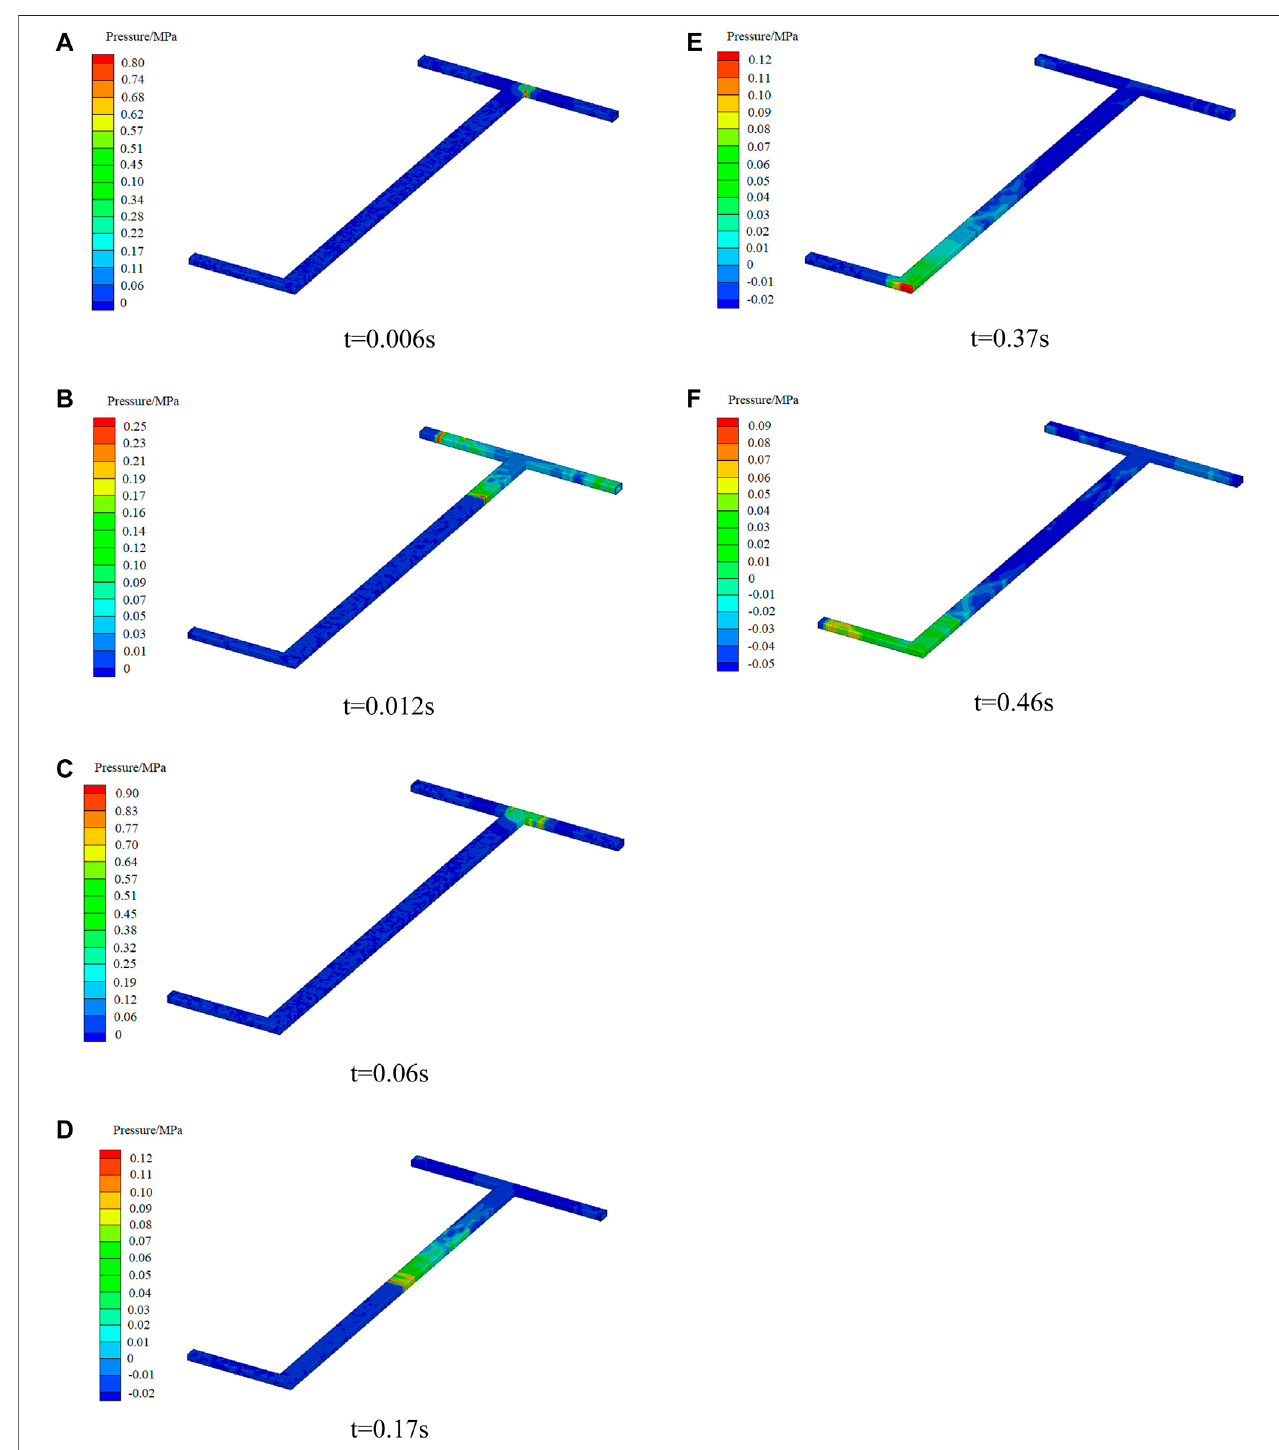
FIGURE5| Clouddiagram ofgasexplosionshockwaveoverpressuredistributionatdifferenttimes inY-type ventilation mode. (A) t = 0.006 s. (B) t = 0.012 s. (C) t = 0.06 s. (D) t = 0.17 s. (E) t = 0.37 s. (F) t = 0.46 s.